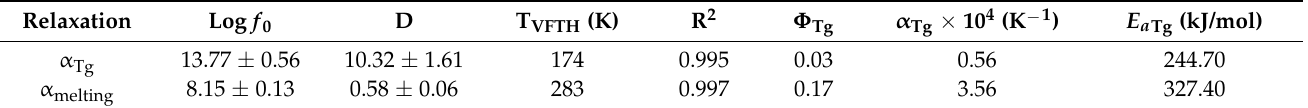
Table 2. Parameters for the VFTH model and derived parameters for studying the dynamic fragility of the neat copolymer